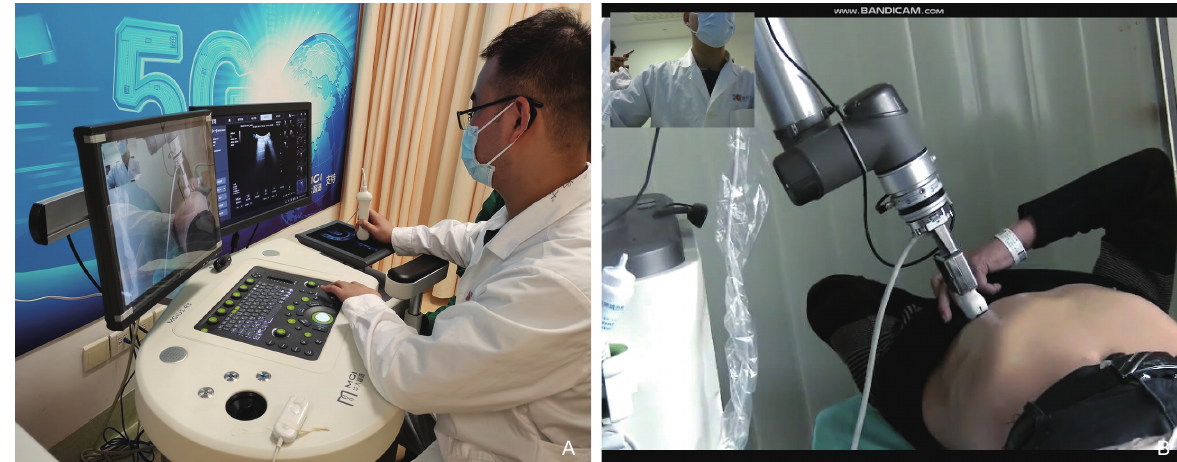
The lung ultrasound manifestation was believed to be consistent with mild pneumonia. Fast and brief assessment of cardiac morphology and cardiac function was carried out by parasternal long axis view and apical four-chamber view, showing good cardiac function (ejection fraction of 64% by M-mode ultrasound) and normal size and morphology. No pericardial effusion, abnormal blood volume, or signs of pulmonary embolism were